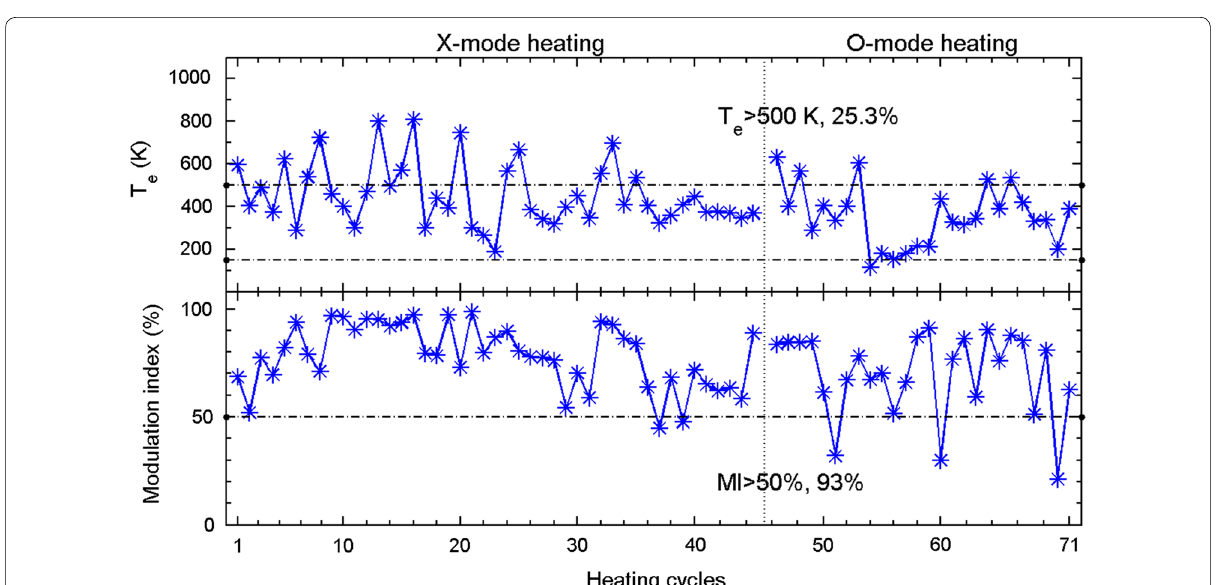
Fig. 9 As for Fig. 7 but for case 3a. In this case, the HF transmitter was operated with one frequency 5.423